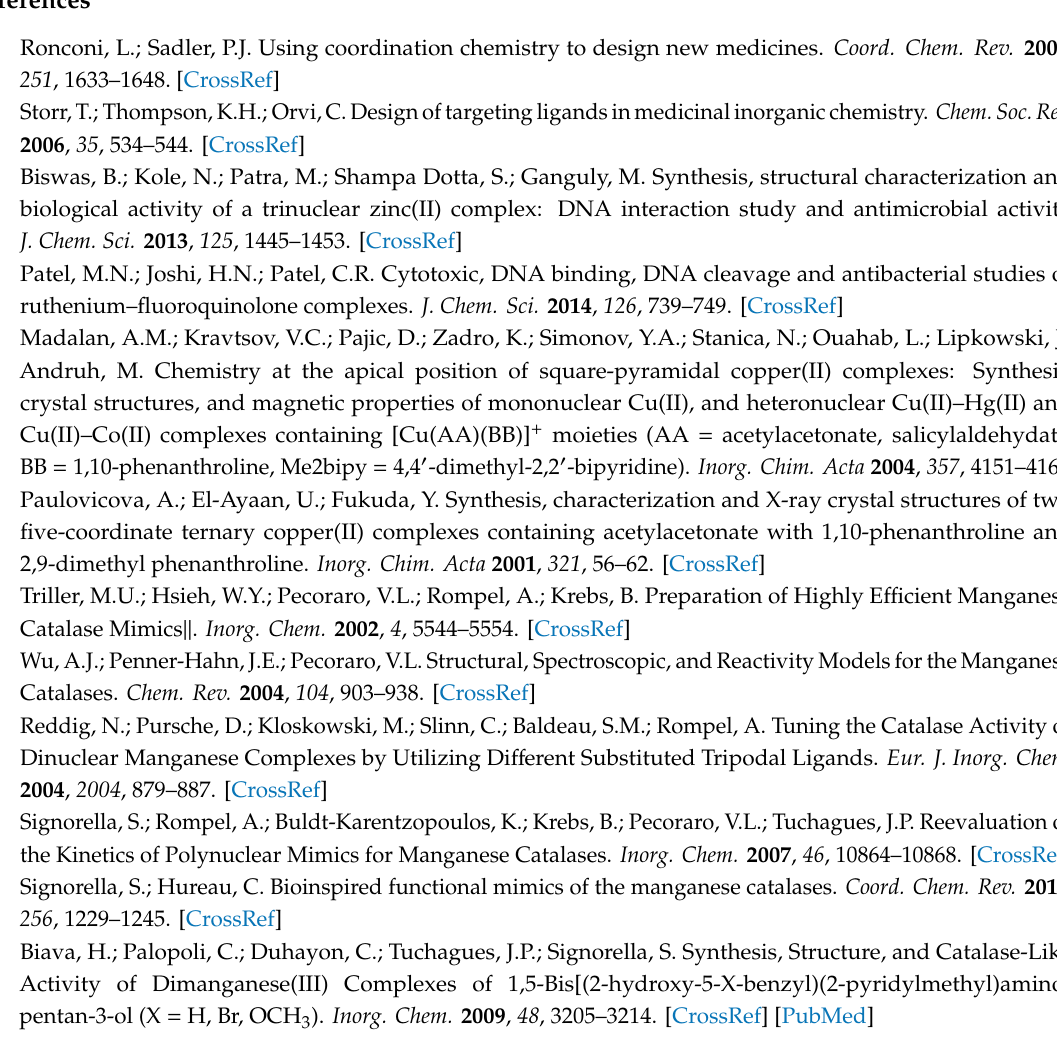
Figure S3 . Anion– π interactions in 1 and 2 . Figure S4 . Hirshfeld surfaces mapped over d norm , shape index and